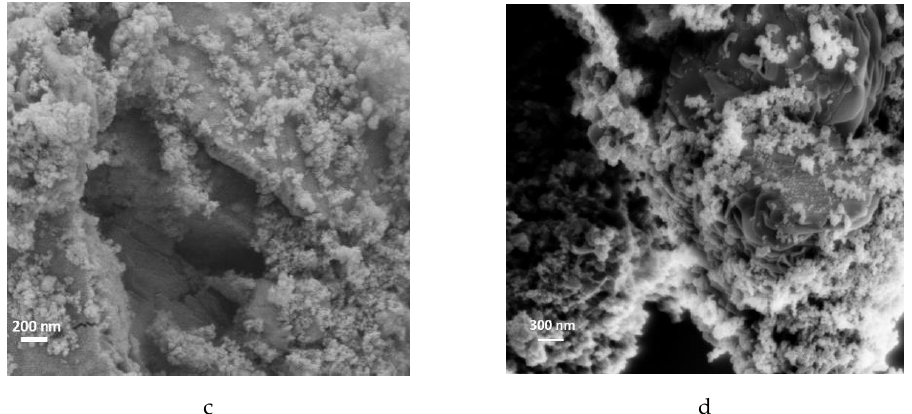
Figure 4. SEM images of ( a ) neat graphene nanoplatelet (GNP), ( b ) neat silica, ( c ) Si:GNP = 1:5 and ( d ) Si:GNP = 1:10 hybrid additives.